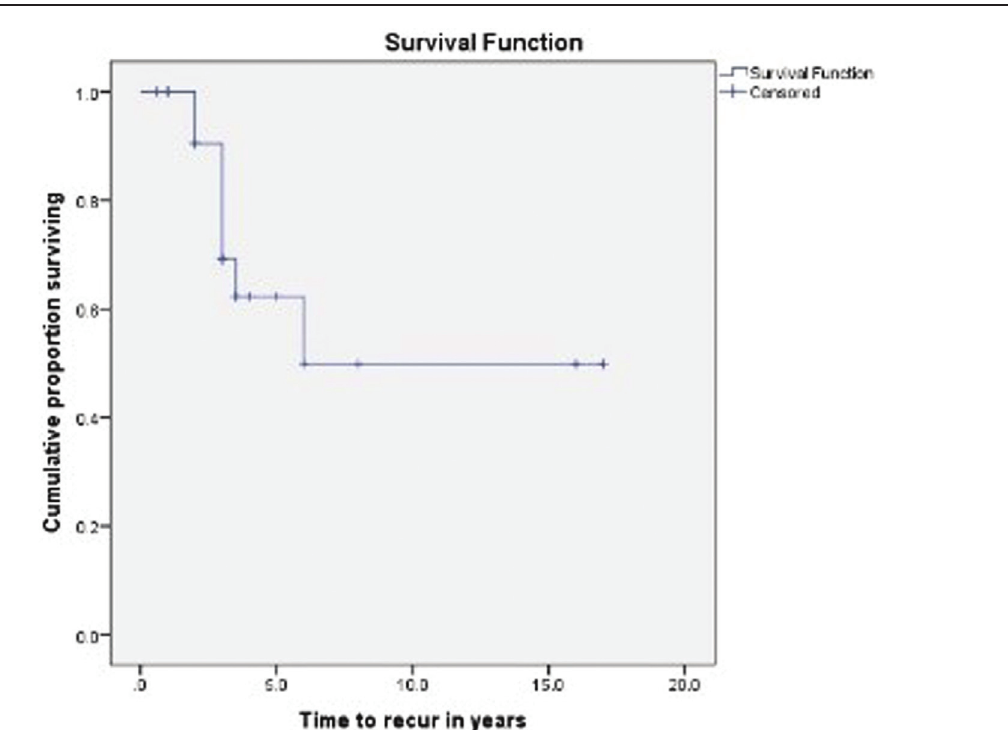
Kaplan – Meier survival curve showing survival pattern of study